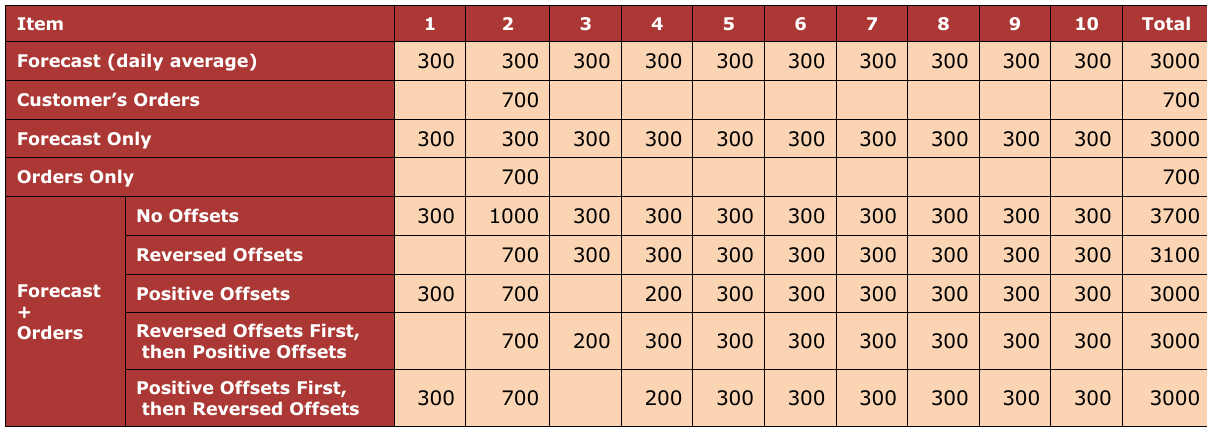
Table 1. Results of Forecast and Customers’ Orders Applying Different Offset